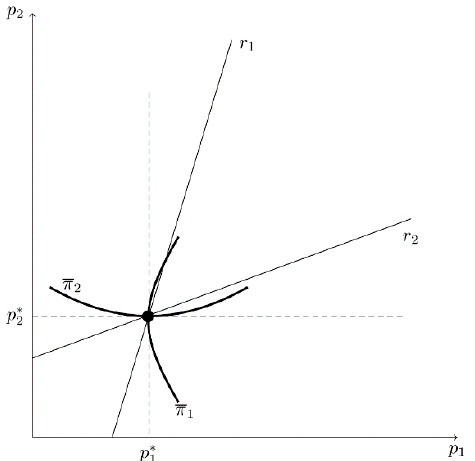
Figure 7. Best Reply Curves, Iso ‐ Profit Curves, and the NE in the Simple Bertrand Model.